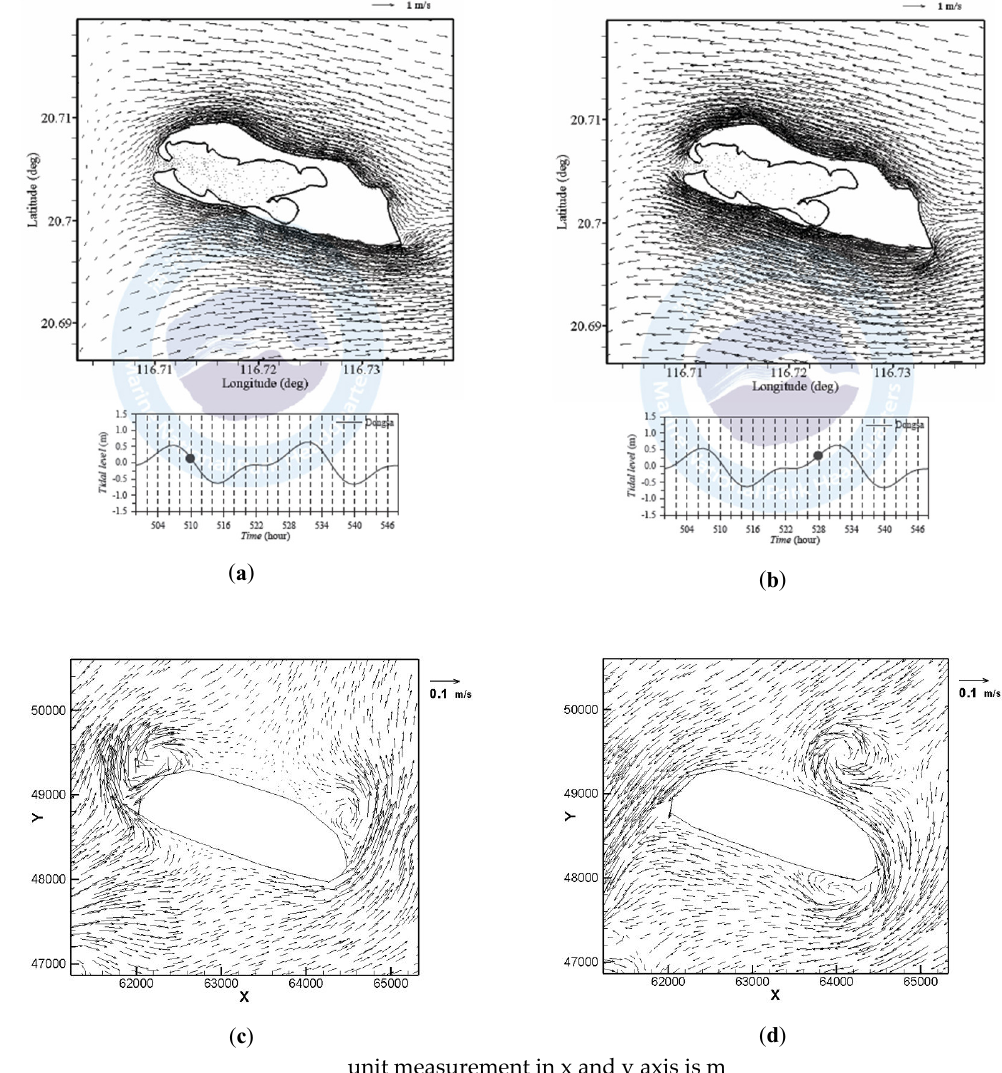
Figure 12. The distribution of flow field near the Dongsha Island at ( a ), ( c ) ebb tides and ( b ), ( d ) flood tides by POM and non-hydrostatic SWM, respectively. (( a ) and ( b ) are from [62]).